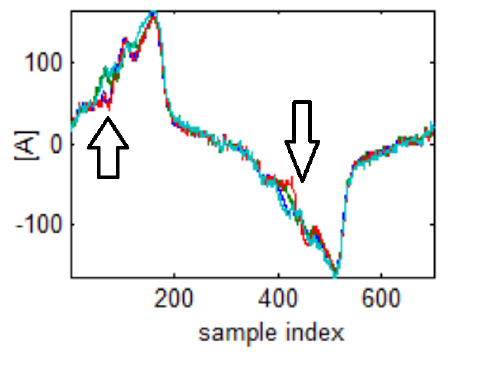
Figure 1. Example of waveforms consid- ered as input data by the hybrid algorithms for denoising electrical waveforms containing steady segments.